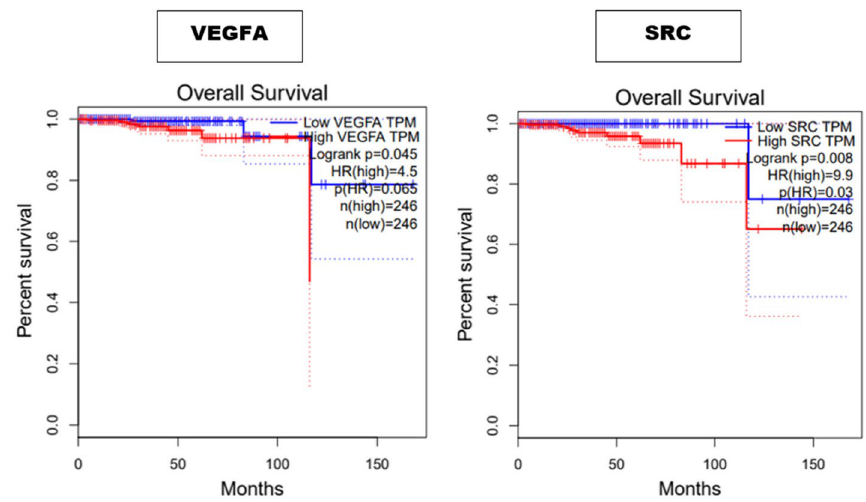
Fig. 7 The contribution of the expression levels of VEGFA and SRC to the OS of PC patients based on TCGA